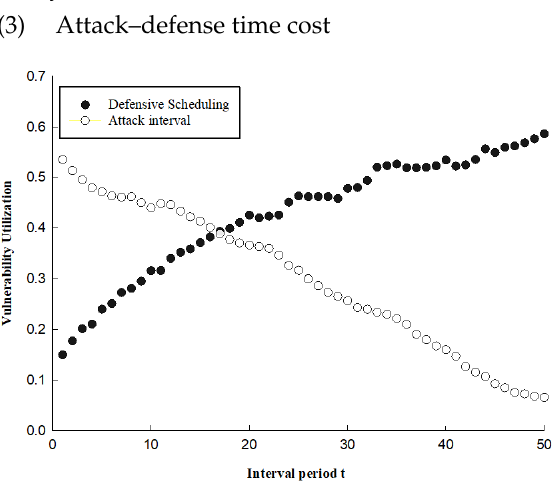
Figure 16. Vulnerability utilization.